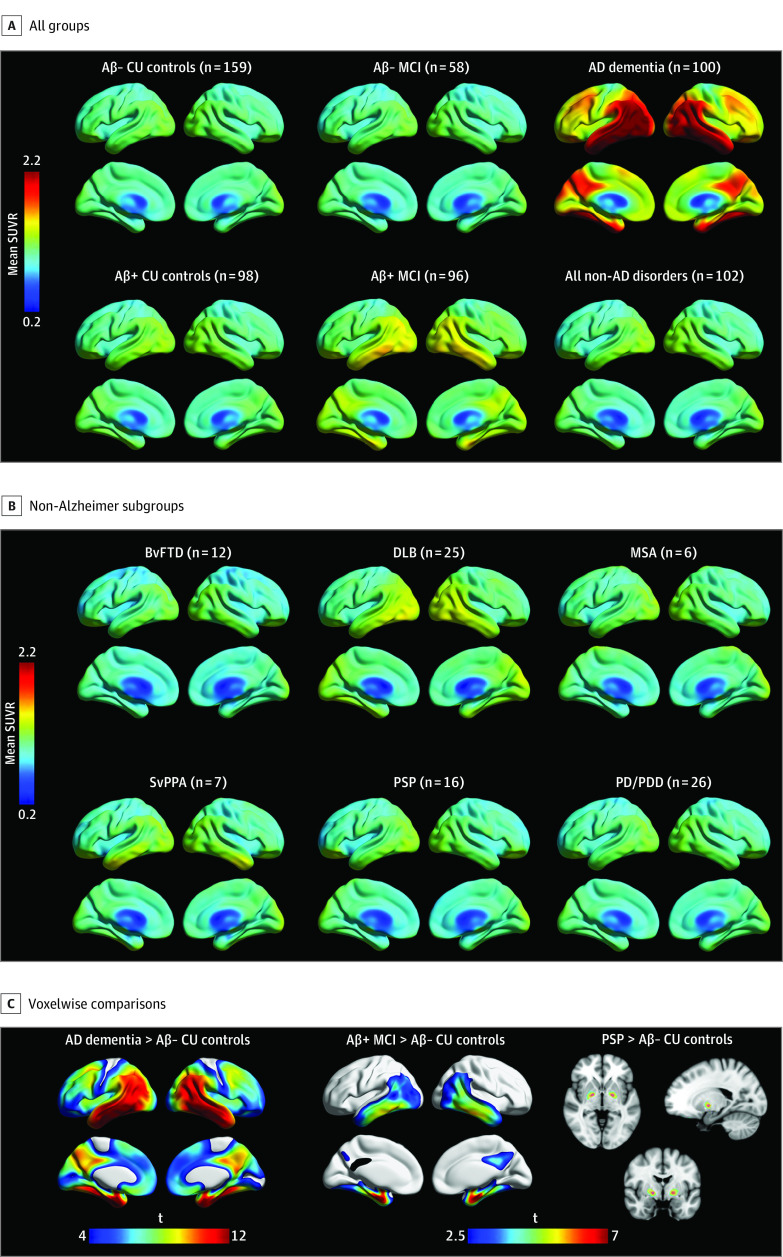
Mean RO948 F 18 ([18F]RO948) Standardized Uptake Value Ratio (SUVR) Images Across Diagnostic GroupsA, Cognitively unimpaired (CU) control individuals and patients with mild cognitive impairment (MCI) and Alzheimer disease (AD) dementia. AD dementia was greater than amyloid β (Aβ)-negative CU controls and Aβ-positive MCI. B, Non-AD subgroups compared with Aβ-negative CU controls. Aβ vs APOE ε4 status (% positive) by non-AD subgroup was as follows: behavioral variant of frontotemporal dementia (BvFTD) (50% vs 33%), dementia with Lewy bodies (DLB) (60% vs 52%), multiple system atrophy (MSA) (33% vs 33%), semantic variant primary progressive aphasia (svPPA) (71% vs 17%), progressive supranuclear palsy (PSP) (38% vs 31%), and Parkinson disease/Parkinson disease dementia (PD/PDD) (23% vs 27%). C, Voxelwise group differences in [18F]RO948 SUVRs. AD dementia, Aβ-positive MCI, and PSP are compared with Aβ-negative CU controls. A cluster threshold of 100 voxels was applied with no correction for multiple comparisons (P < .001). t indicates t value.